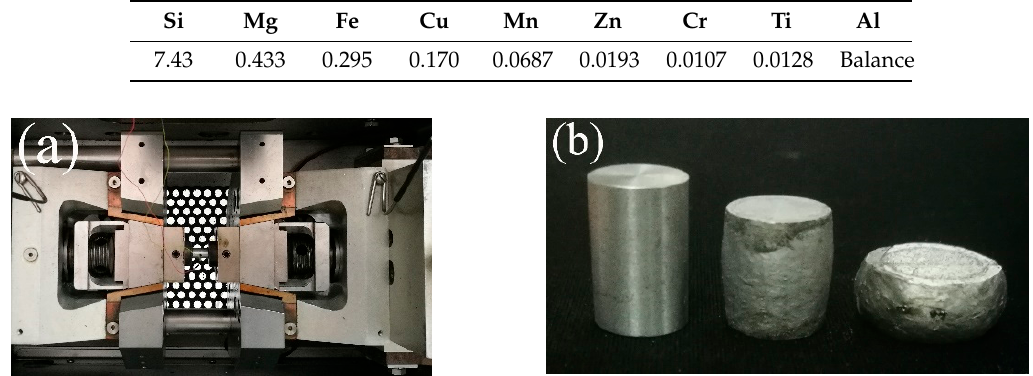
Table 1. Chemical composition of the Al–Mg–Si alloy (wt %).